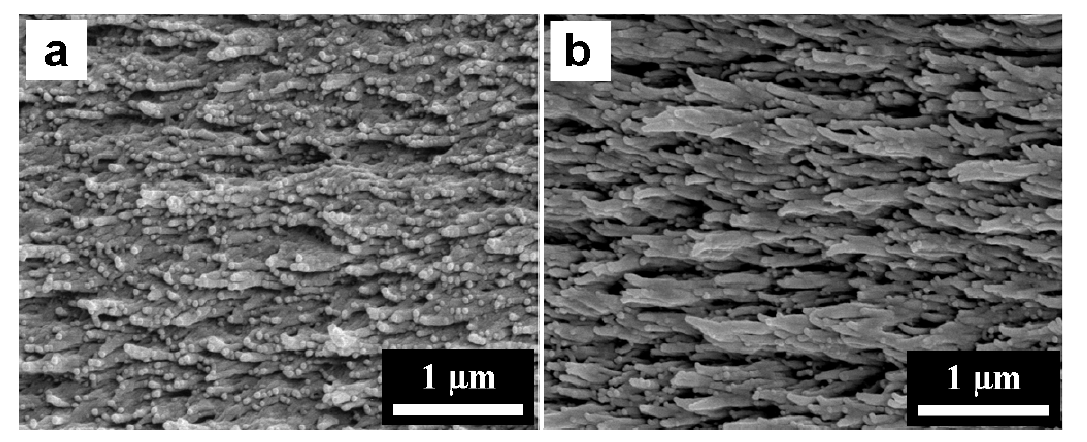
Figure 4. SEM cross-sectional morphology of: a) cellulose film, b) M/C composite and c) aligned M/C composite.